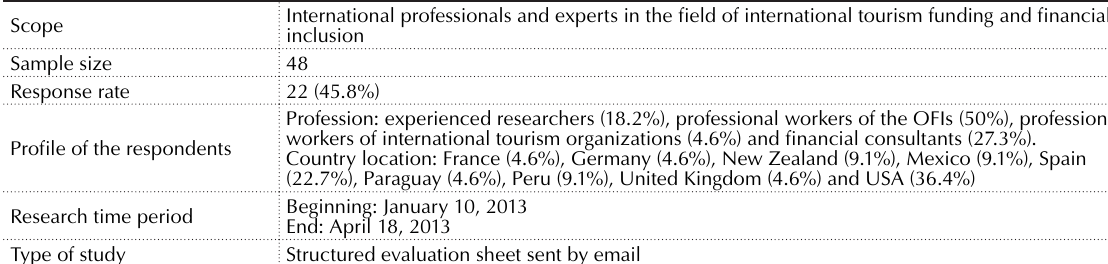
Source: Authors’ own